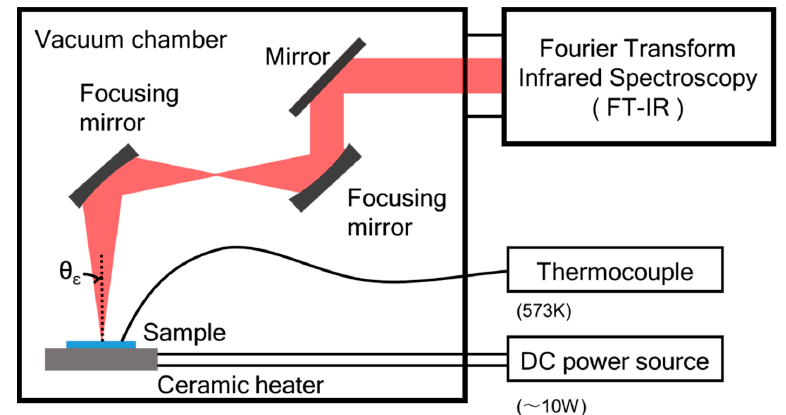
Figure A4. Fabricating the refractory MDM metasurface.